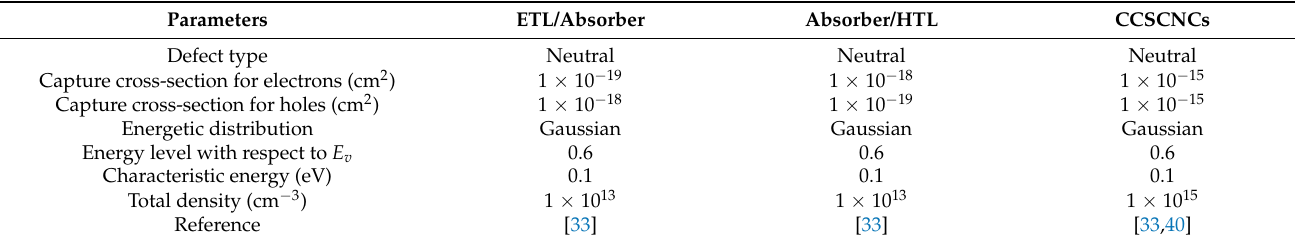
Table 2. Input parameters for ETL of the PSC structure.